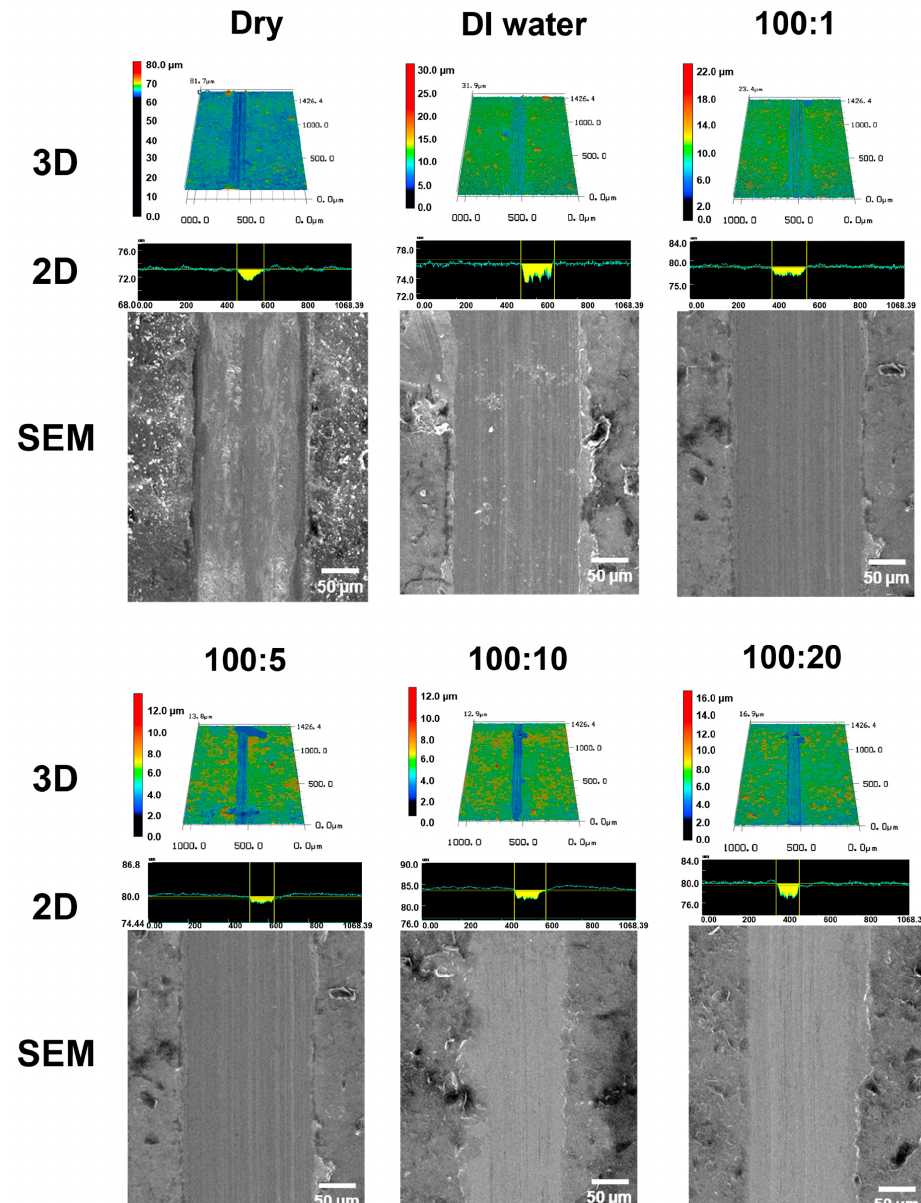
Figure 3. 3DLaser scanning confocal microscope and SEM images of wear tracks with respect to the lubrication conditions under 200 mN after 10,000 cycles.